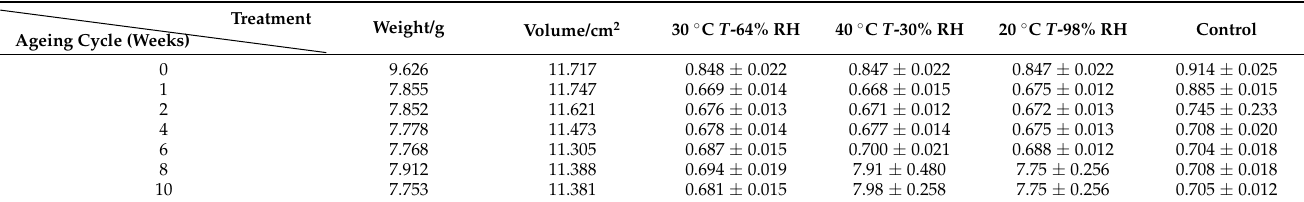
Table 2. Humid heat cycle ageing data records on bamboo density